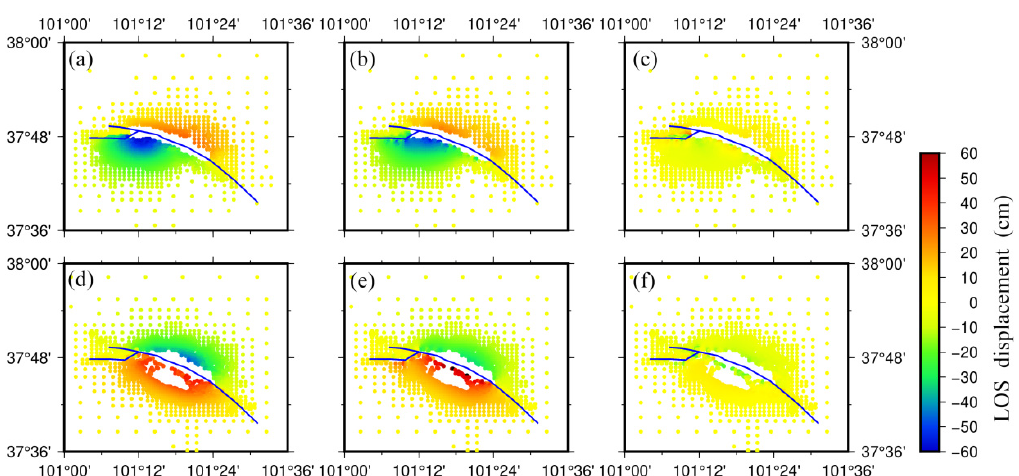
Figure 10. ( a , d ) The downsampled InSAR LOS displacements. ( b , e ) The modelled LOS displacements from the joint inversion. ( c , f ) Residuals based on the preferred rupture model (Figure 7). Blue lines are surface projections of the fault model used in the joint inversion.